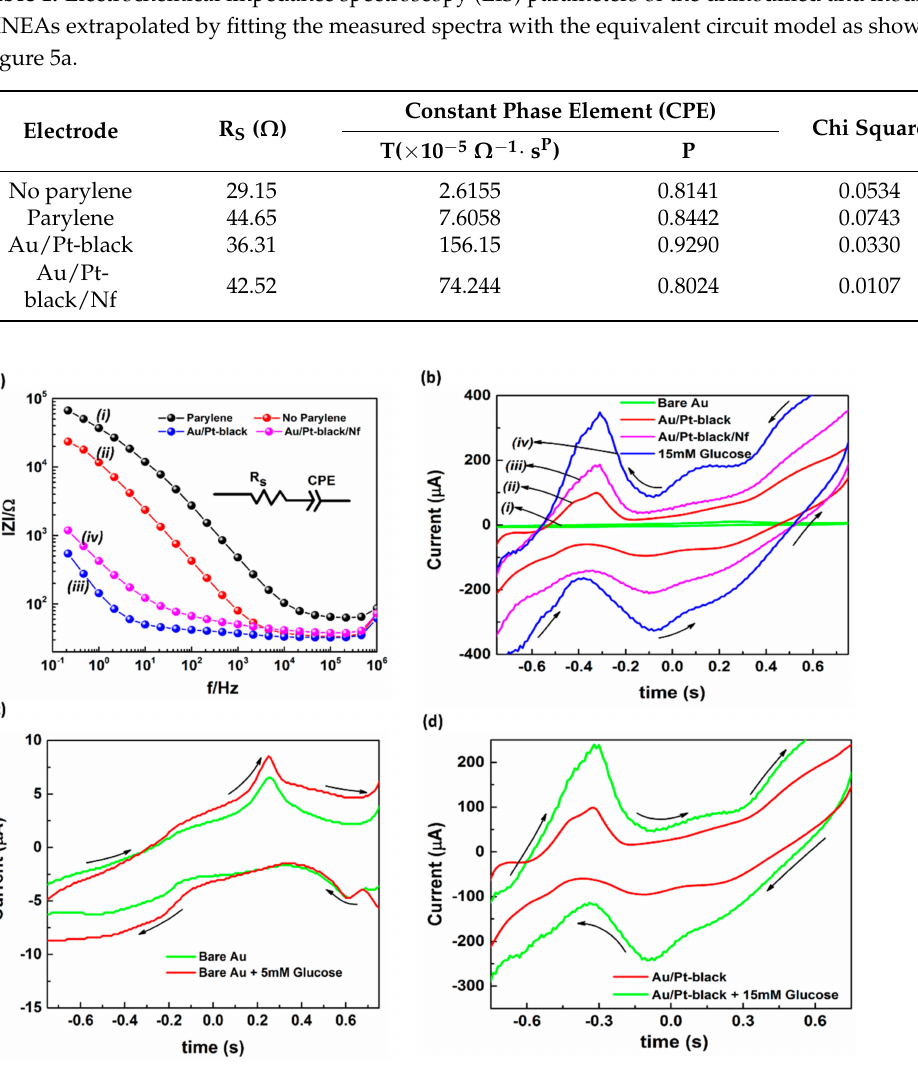
Figure 3. Impedance spectra of the bare Au MNs with and without parylene coating (i and ii), Au/Pt black MN (iii) and Au/Pt black/Nf MN (iv) carried out in 0.9% NaCl at a frequency range of 0.1 Hz to 1 MHz ( a ). Cyclic voltammograms (CV) of the bare Au (i), Au/Pt-black (ii), and Au/Pt-black/Nf MNs (iii) with 15 mM glucose addition (iv) at a scan rate of 50 mV · s − 1 in 10 × PBS (pH = 7.4) ( b ). The CV of the bare Au MNEA and Au/Pt-black MNEA showing the response of the electrodes with and without glucose addition ( c , d